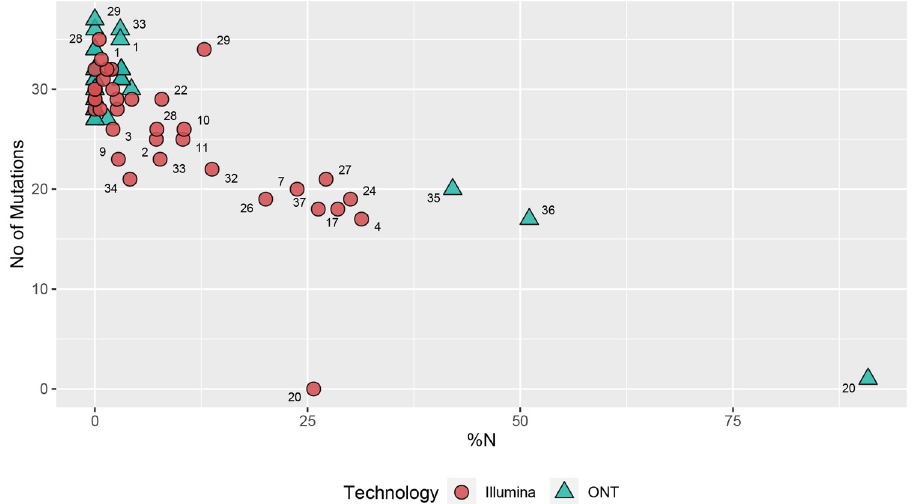
Fig 3. Percentage of ambiguous bases (% of N) compared to the no of mutations (SNP) detected in each sample. The trend between percentage of ambiguous bases is shown in the x axis and number of mutations projected onto the consensus sequences is shown in the y axis. The numbers displayed on each shape denotes the sample identification number (n = 37) sequenced by Illumina (red) or ONT (blue). Both technologies had detected a maximum SNPs with 1% - 5% ambiguous bases. The consensus sequences generated by Illumina had a varying percentage of ambiguous bases between 1% - 30%, whereas ONT sequencing generated either < 5% or more than 40% ambiguous bases due to its longer read lengths. Altogether ONT had detected more SNPs than Illumina between of 1% - 5% ambiguous bases.